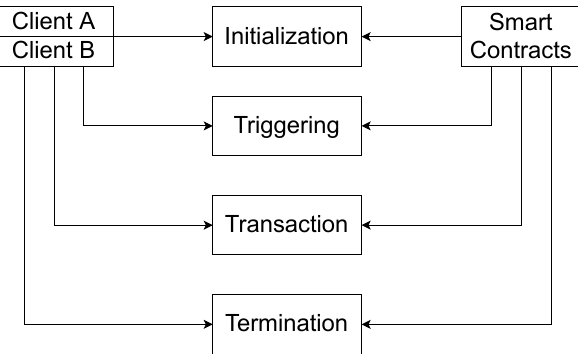
Figure 1. Interaction between clients and smart